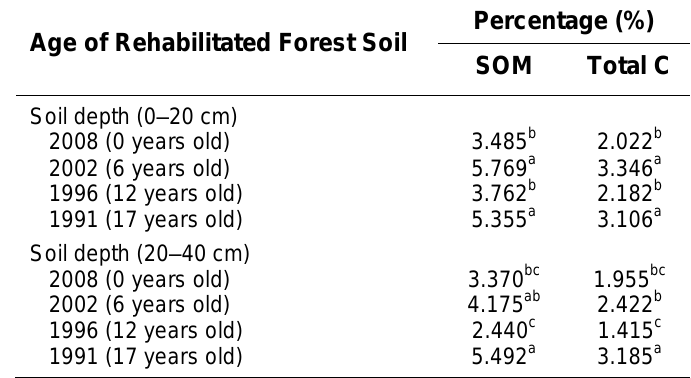
Age of Rehabilitated Forest